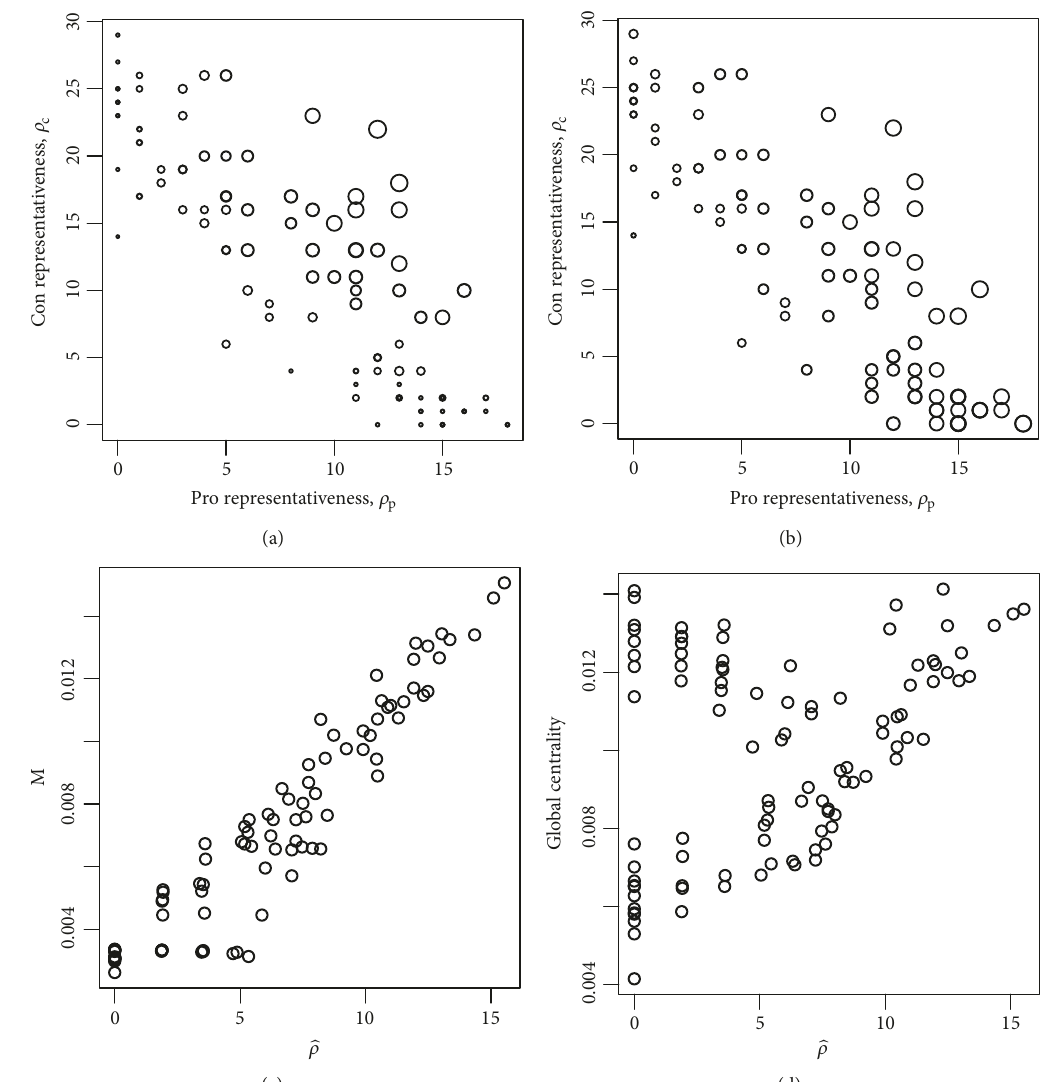
Figure 7: Comparison of mediation representativeness against mediation centrality and global centrality in Simulation 2. Each individual is represented by a dot. (a) Representativeness for pro and con reasons. Dot size represents mediation centrality. (b) Representativeness for pro and conreasons. Dot size representsglobalcentrality.(c)Global representativenessagainst mediation centrality.(d) Global representativeness against global